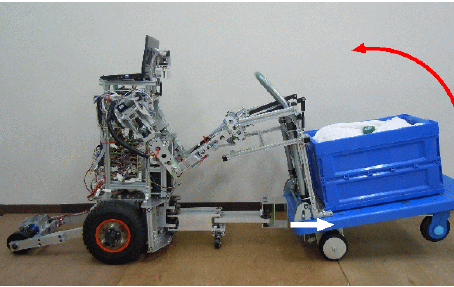
Figure 5. Extendable robot front-wheel mechanism.